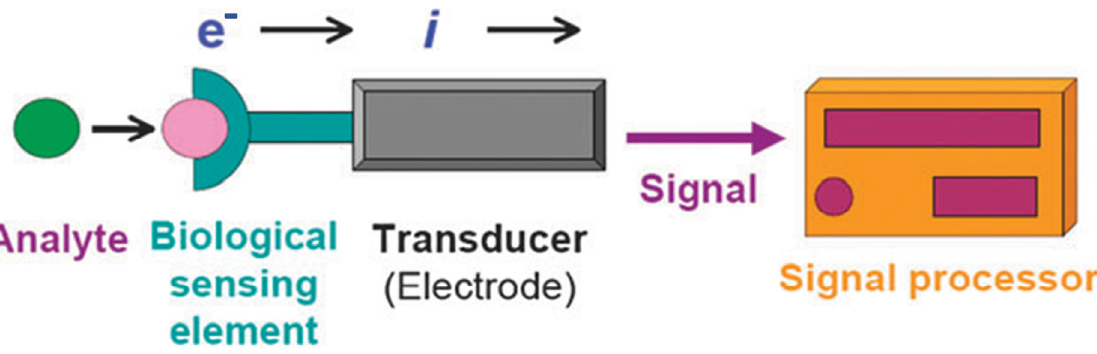
Figure 1. A schematic showing a nanobisensors with electrochemical transducer and other compo- nents. Reproduced with permission from [3].